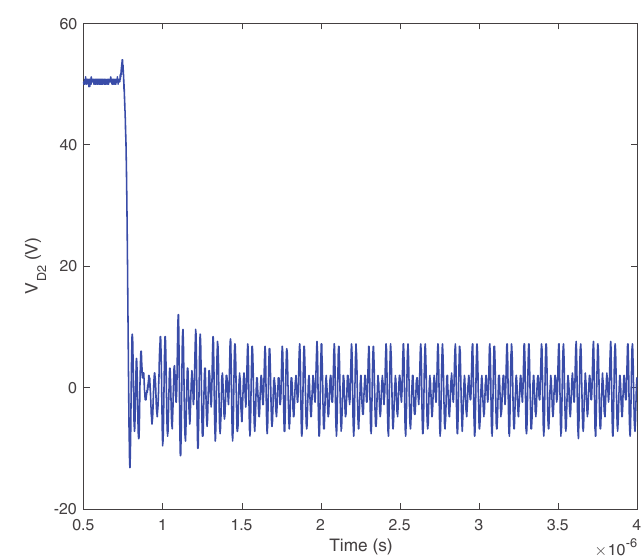
Figure 11. The waveforms of V D 2 (Polarities defined in Figure 2).